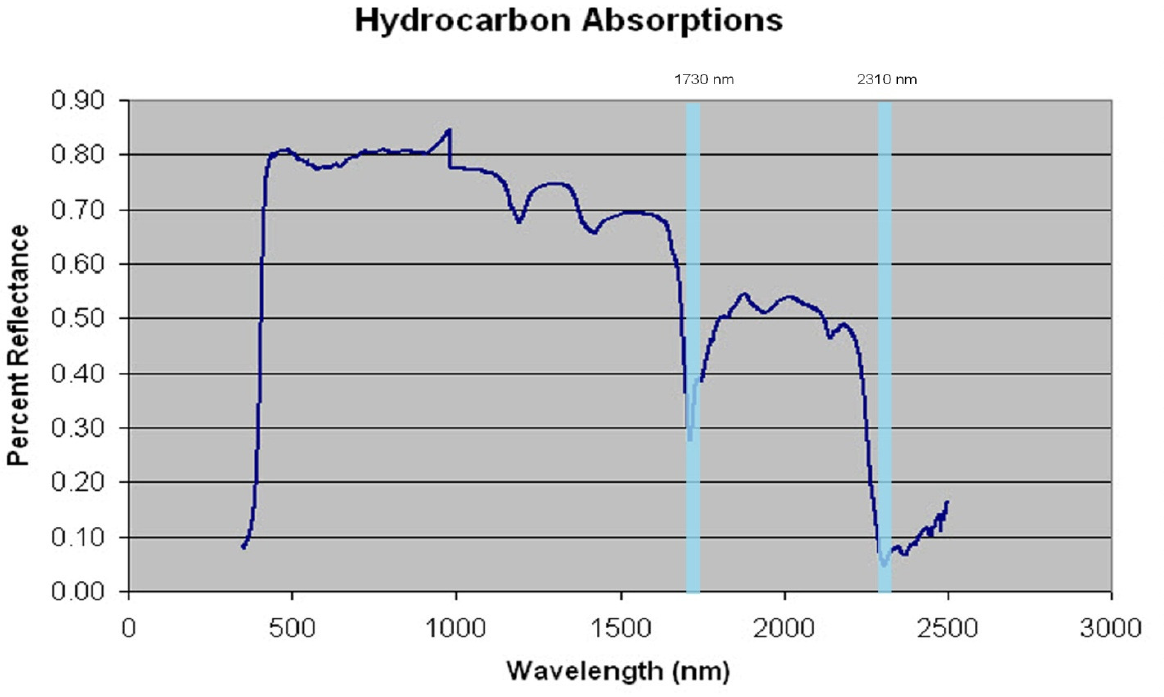
Figure 13. Hydrocarbons have distinctive absorption patterns in the near infrared at approximately 1,730 and 2,310 nm. From Allen